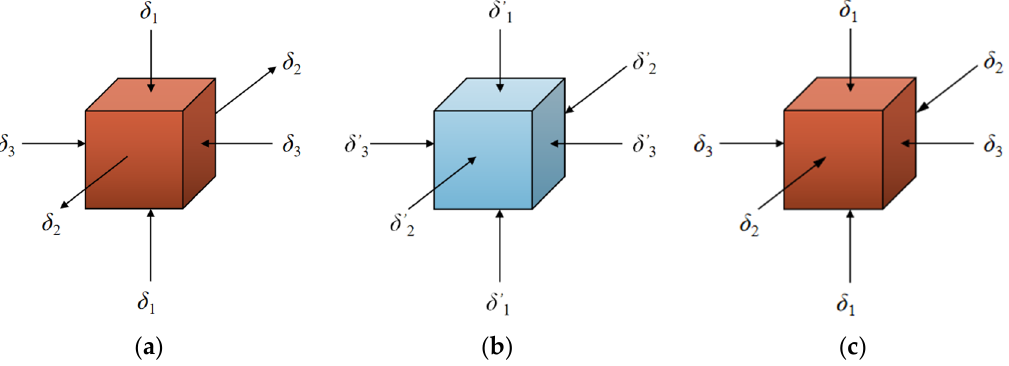
Figure 18. Schematic diagram of element microstress: ( a ) steel tube; ( b ) concrete; ( c ) H-shape steel.